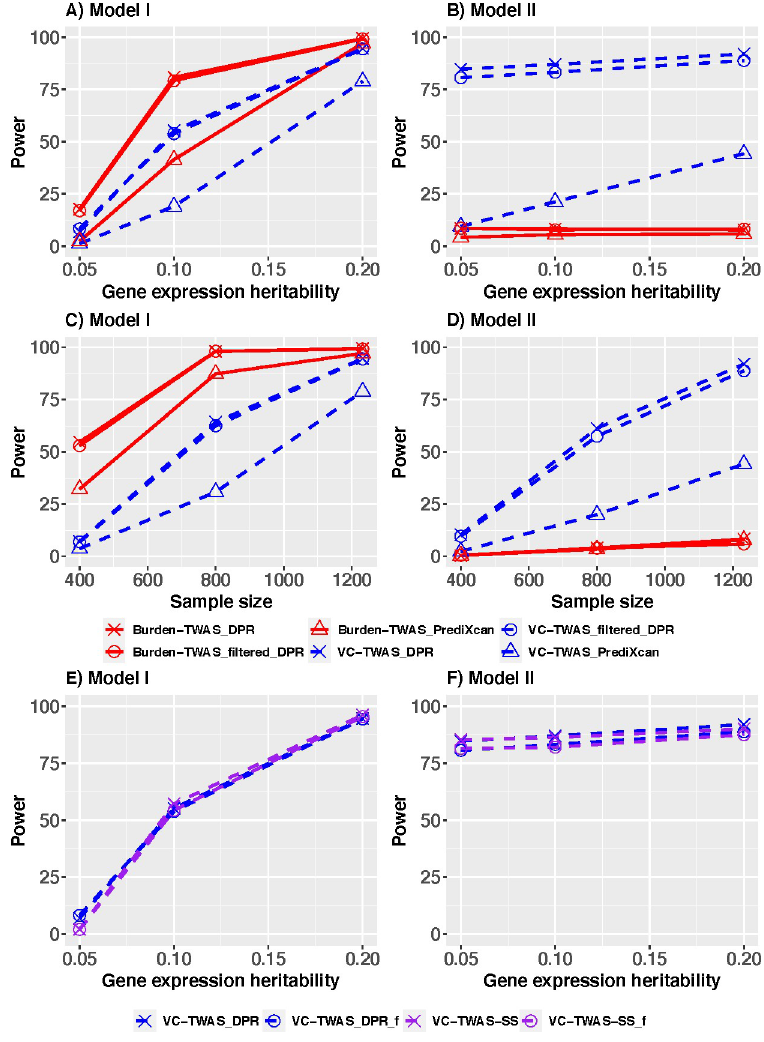
Fig 1. Power comparison of Burden-TWAS and VC-TWAS methods under simulation scenarios with 20% true causal eQTL for gene expression (i.e., p causal = 0.2) in the test gene. Phenotypes simulated from Model I (A, C, E) and Model II (B, D, F) were considered. Various gene expression heritability and various types of SNP weights were considered, including those derived from PrediXcan method, DPR method, and filtered DPR weights in panel (A, B). Various test sample sizes (400, 800, 1232) were considered in panel (B, D). The VC-TWAS approach of using only summary-level GWAS data were validated in panel (E, F).